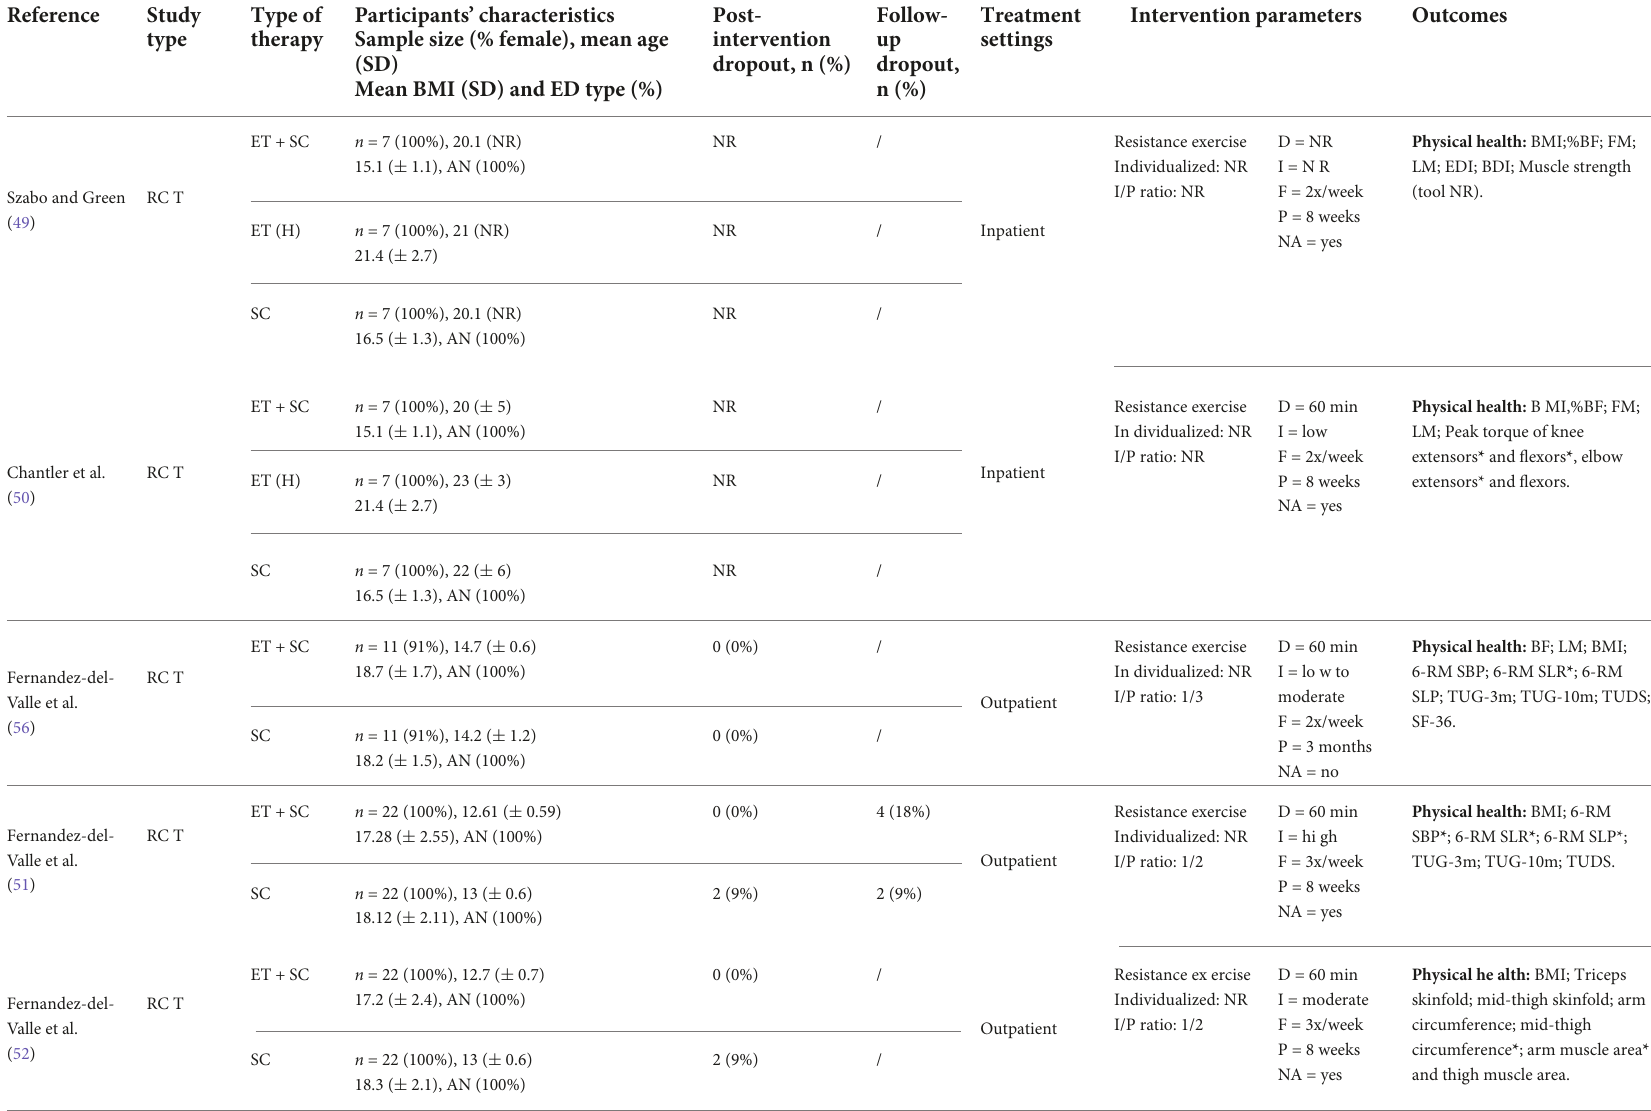
TABLE 4 Characteristics and main results of studies (RCT, NRCT, UT) conducted on effects of resistance exercise in patients with